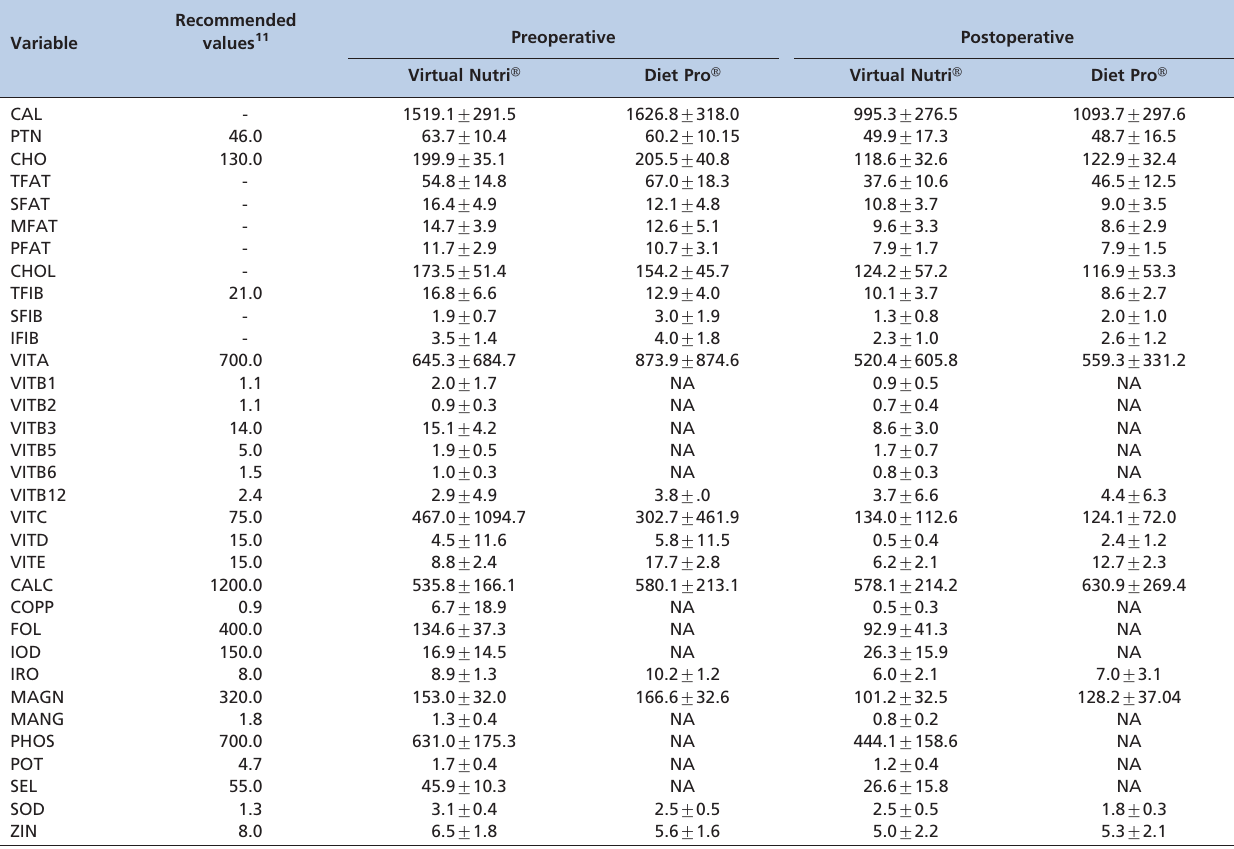
Table 2 - General nutritional data (means ¡ standard deviation) of obese women with T2DM (n= 10) obtained before and 3 months after RYGB using the 7-day record to determine food intake and either the VNP or DP program to estimate the nutritional